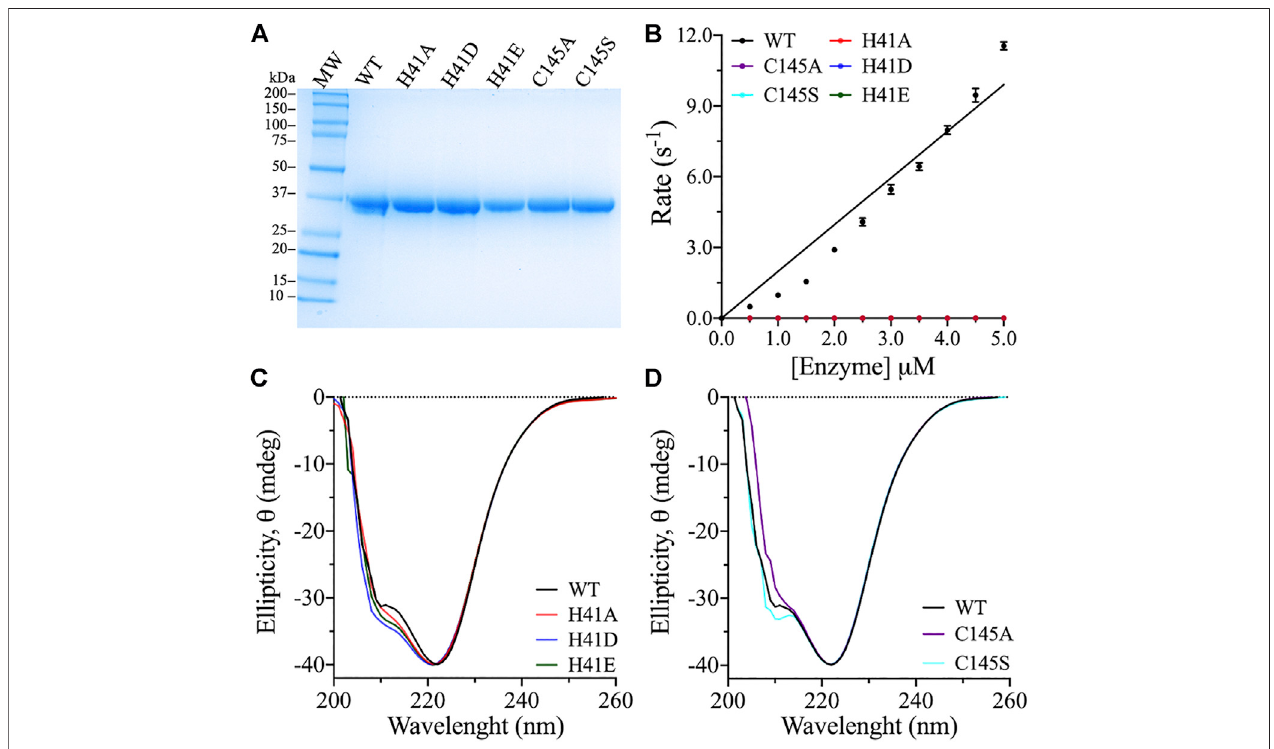
FIGURE 2 | Purity, titration analysis, and structural fold conformation of 3CLpro variants. (A) The purity of 3CLpro WT and its variants was assessed by resolving around 25 μ g protein on SDS – PAGE gel, with Coomassie Brilliant Blue staining for protein band visualization. The molecular mass marker and 3CLpro variants are as labeled with theoretical molecular weight of 38.5 kDa for the 3CLpro enzyme. The gel band densitometry was performed using ImageJ software. (B) Cleavage rates of the 3CLpro WT and variants at 30 ° C. The WT was the only active enzyme form. Data are presented as the mean ± SD, n (cid:2) 3. (C,D) Far UV-CD spectra (260 – 200 nm) of the 3CLpro WT and variants. The CD scans were collected at 25 ° C in phosphate buffer (pH 7.5). Each scan is an average of fi ve CD scans.